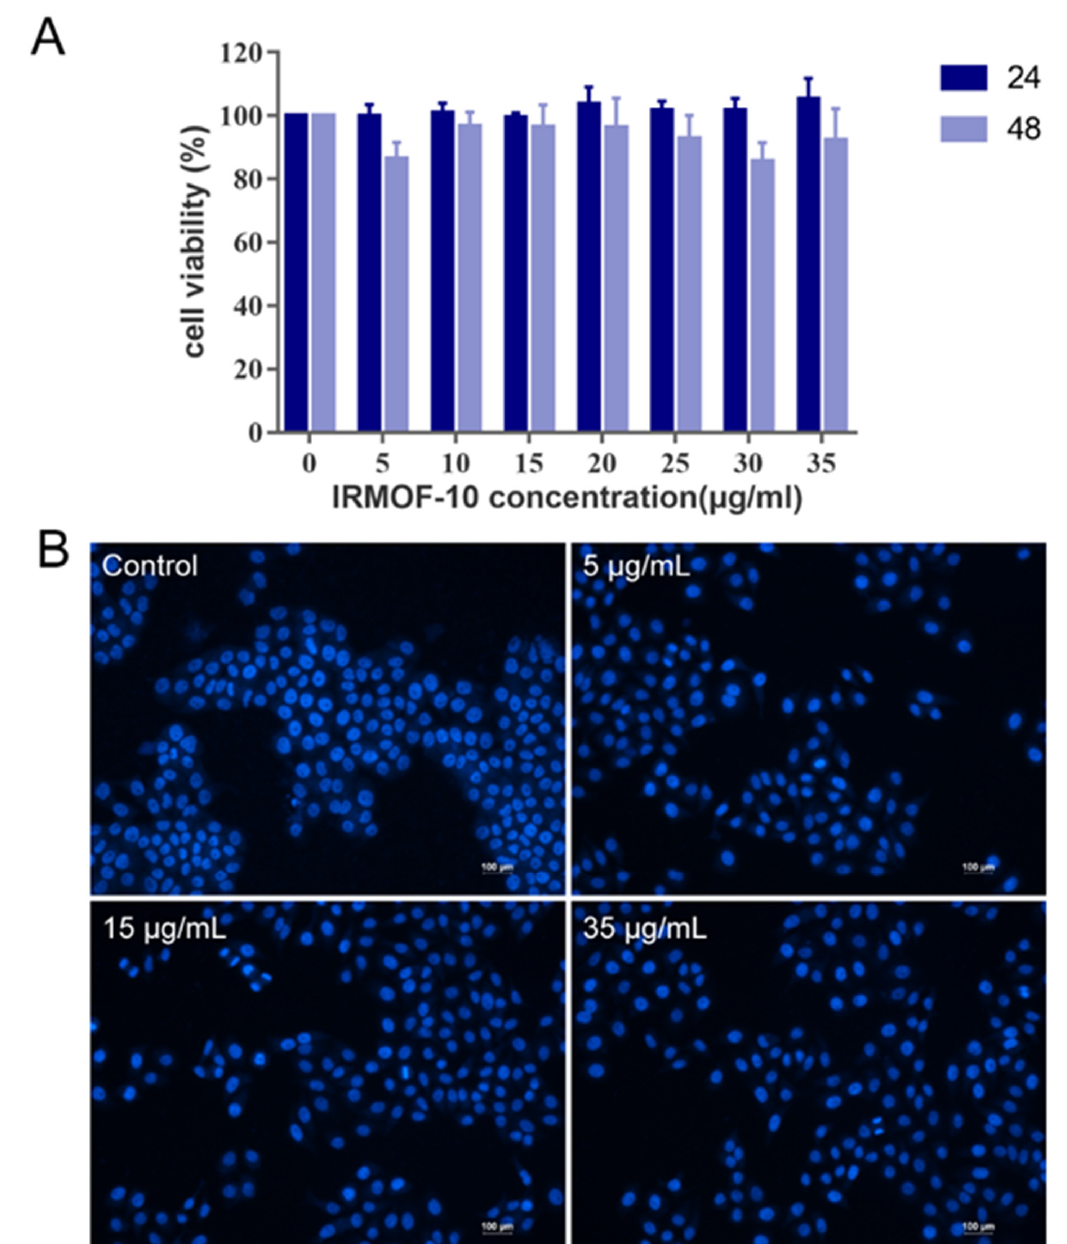
Figure 7. Safety of IRMOF-10: ( A ) MTT method to determine the safe concentration range of IRMOF- 10 for HepG2 cells; ( B ) fluorescence micrographs of HepG2 cells stained with DAPI after 24 h of treatment with three concentrations of IRMOF-10.